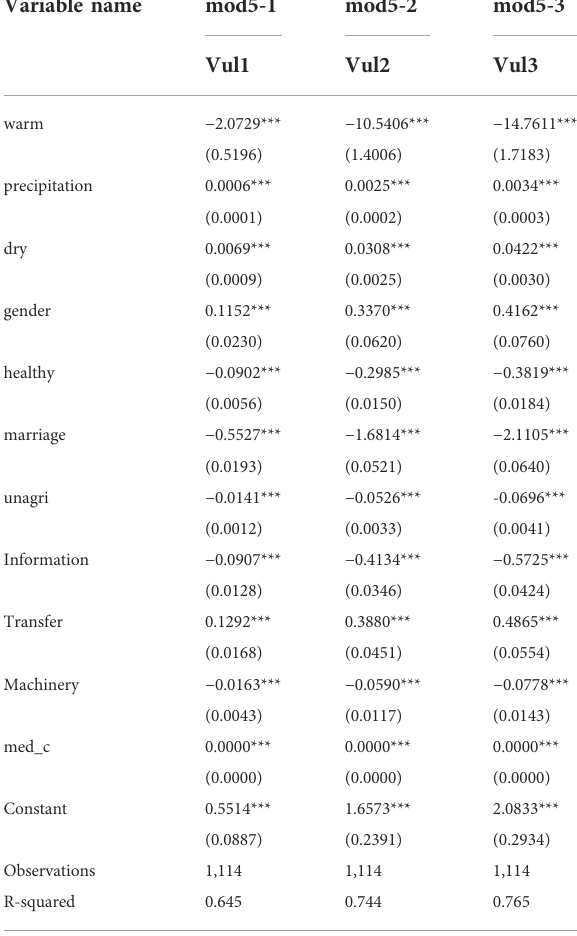
TABLE 5 Baseline regression results of the impact of extreme weather on poverty vulnerability of farm households. Variable